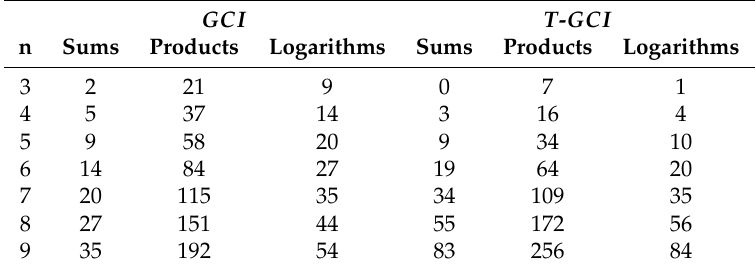
Table 2. Computational complexity of GCI and T - GCI for different values of n . GCI T -